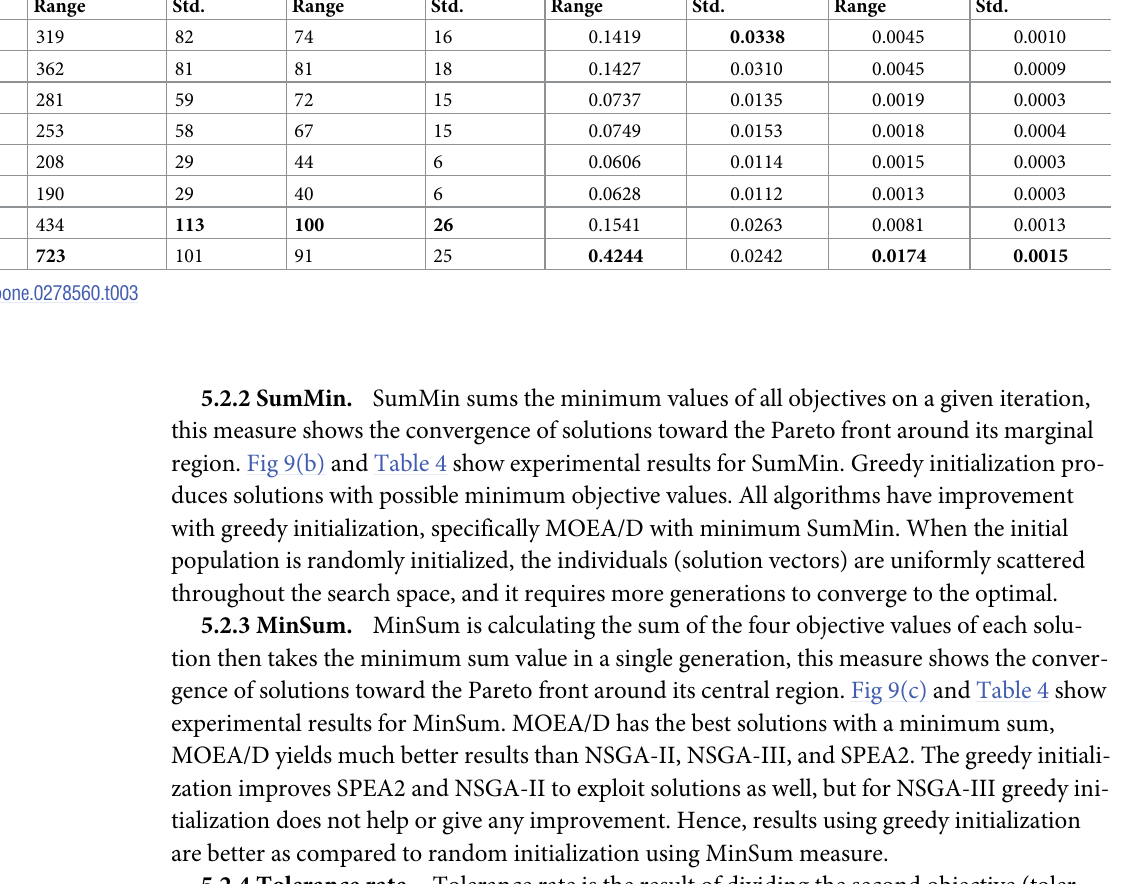
Table 3. Spread for objectives 1 to 4 of NSGA-II, SPEA2, NSGA-III, and MOEAD using RI random initialization in Fig 1 and GI greedy initialization in Fig 2.